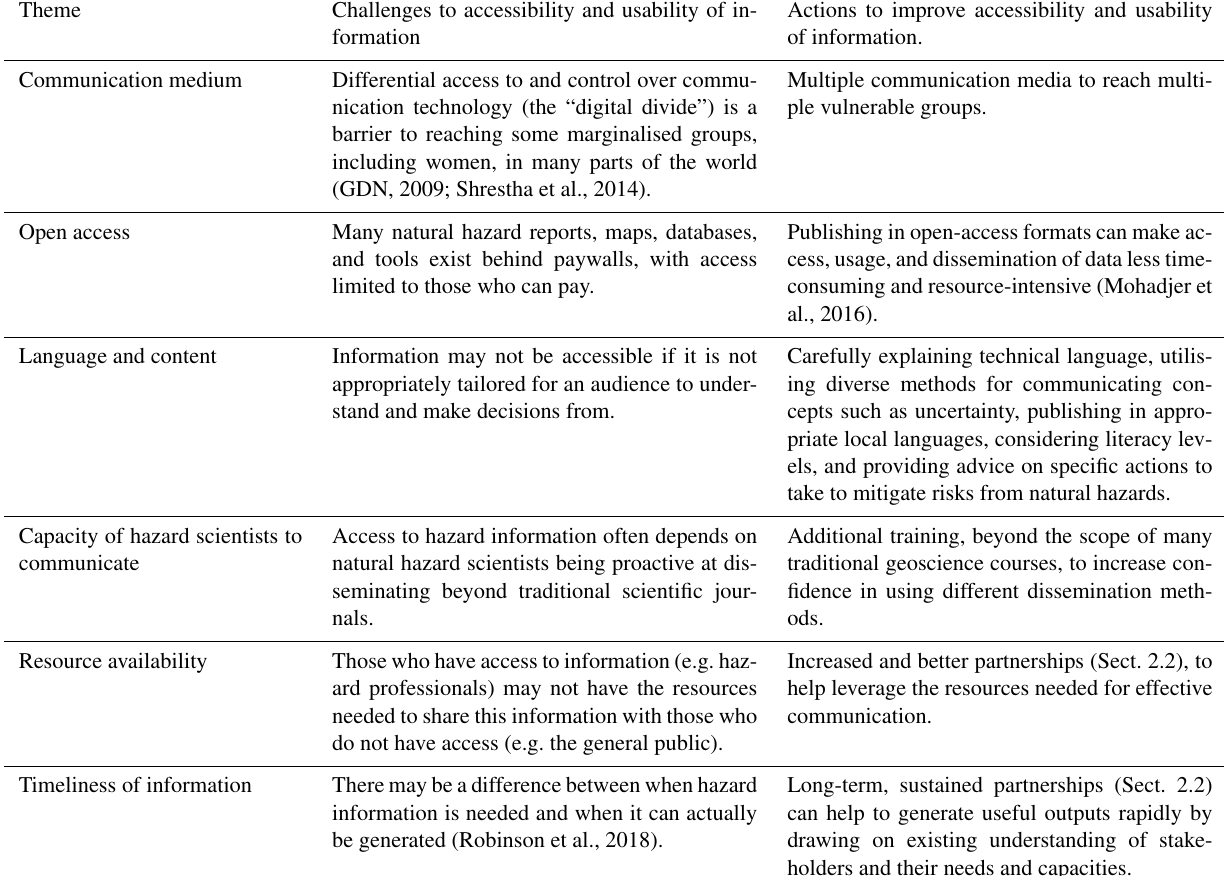
Table 2. Accessibility and usability of hazard